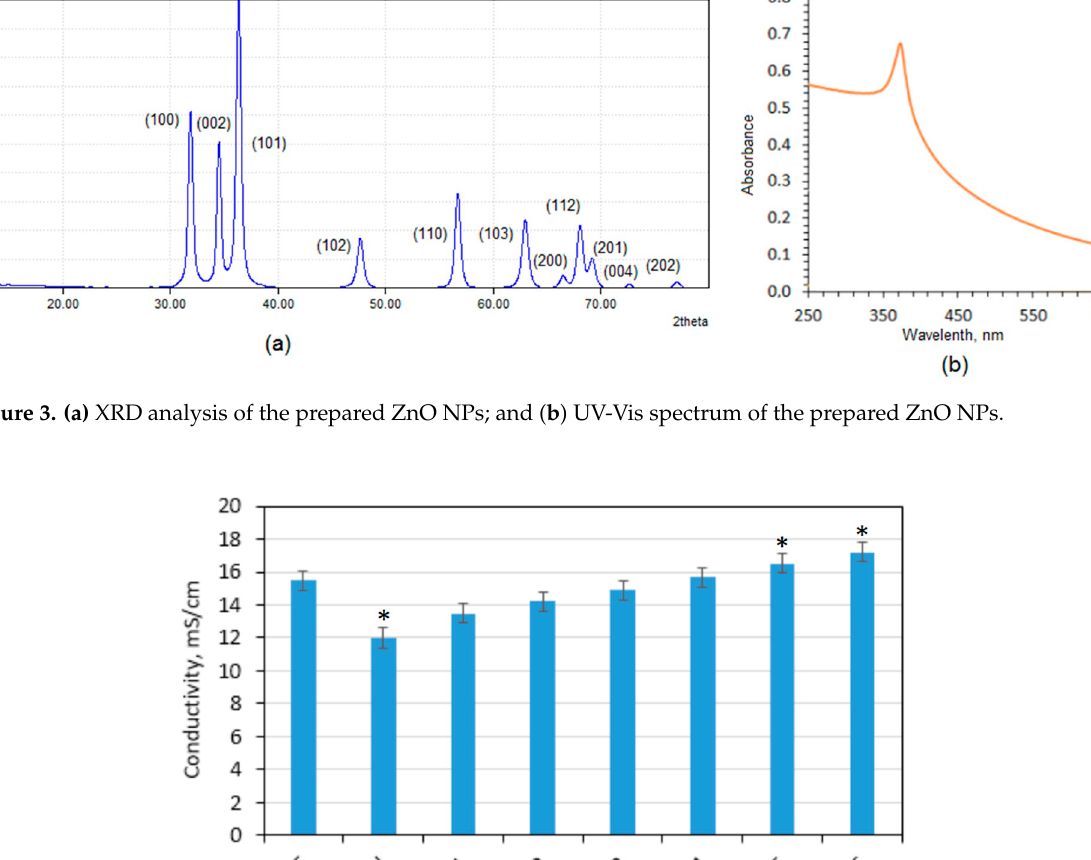
Figure 3. (a) XRD analysis of the prepared ZnO NPs; and ( b ) UV-Vis spectrum of the prepared ZnO NPs .